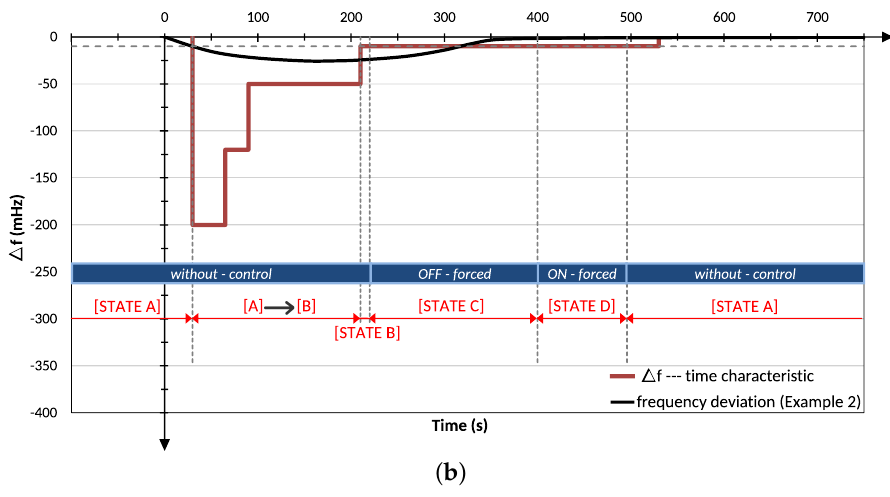
Figure 7. Load control scheme examples for two representative cases. ( a ) Example 1: growing frequency deviation; ( b ) Example 2: disappearing frequency